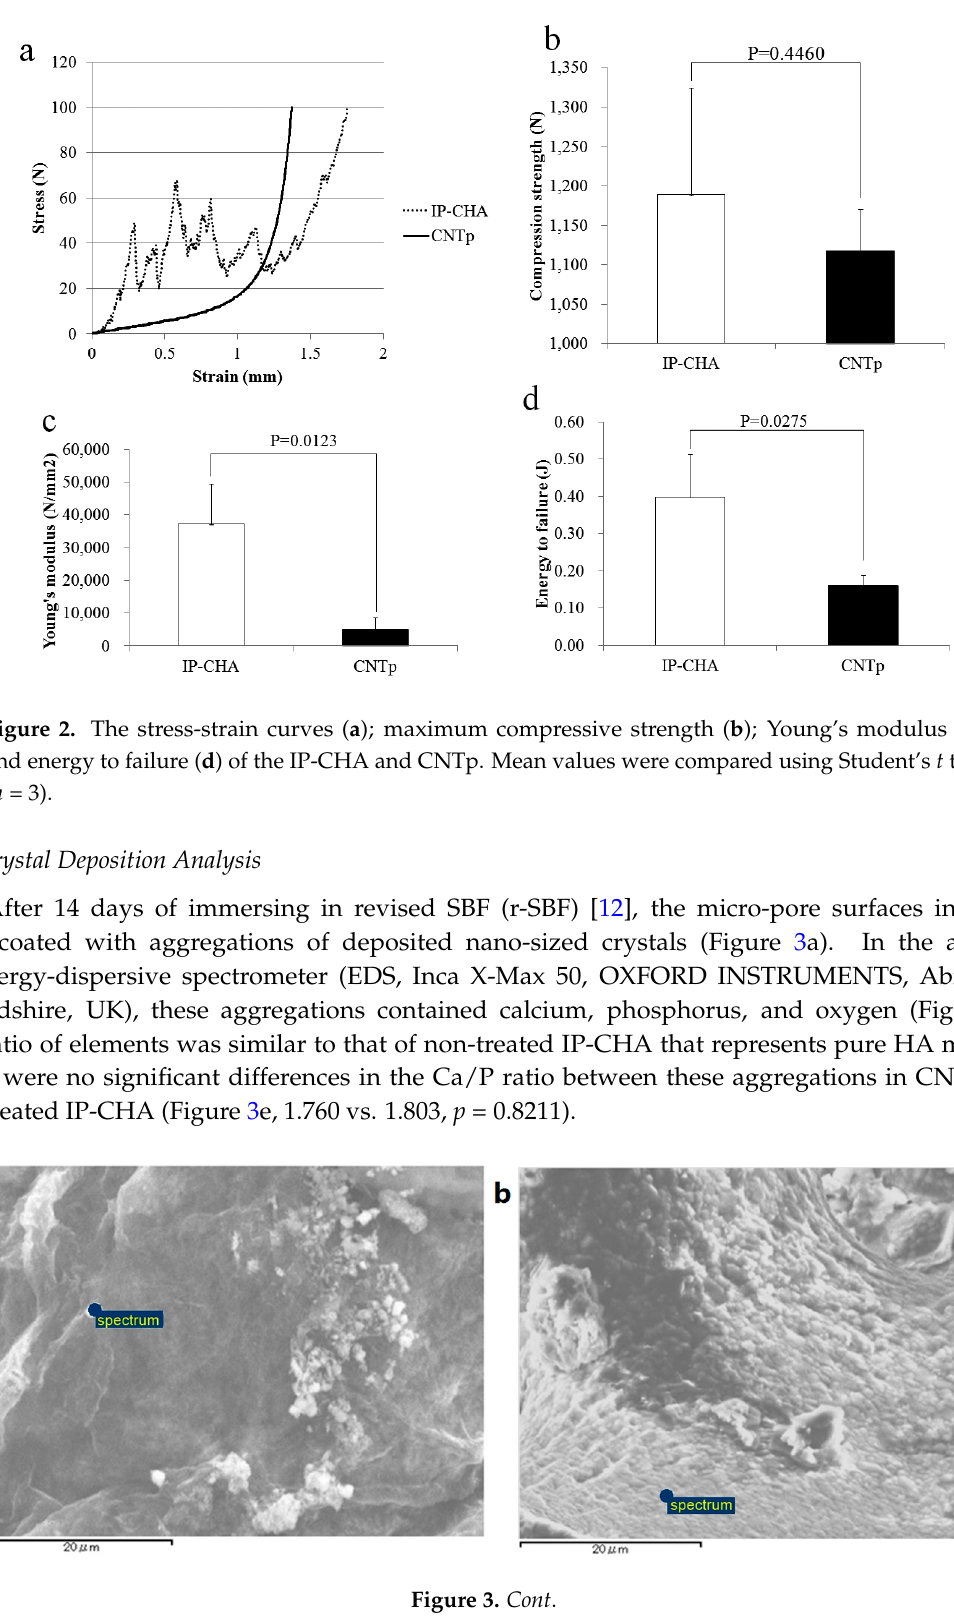
Figure 3. ( a ) SEM image of hydroxyapatite ‐ like crystal formation on CNTp scaffolds; ( b ) SEM image of a non ‐ treated IP ‐ CHA; ( c , d ) EDS on marked area revealed Ca, P, O in the crystal on ( c ) CNTp and ( d ) the surface of non ‐ treated IP ‐ CHA; ( e ) Ca/P ratio of the crystals appeared on the surface of CNTp and IP ‐ CHA. Mean values were compared using Student ʹ s t test ( n = 5). 2.4. Qualitative Protein Adsorption Profiles Each sample was immersed into 500 μ L of 500 μ g/mL Bovine Serum Albumin (BSA) solution (each solution contained 250 μ g of BSA). On day 0 (one hour of immersion), CNTps showed significantly faster protein adsorption than IP ‐ CHAs ( p = 0.0104). On day 4, CNTps decreased more protein concentration in the solution compared to IP ‐ CHAs ( p = 0.0006). Similar data was obtained on day 7 ( p = 0.0042). IP ‐ CHAs did not show further decrease of protein concentration on days 4 and 7 compared to day 0 (Figure 4). Total amounts of protein that adsorbed to CNTps and IP ‐ CHAs on day 7 were 100 μ g and 12 μ g, respectively. Considering the porosity of CNTps (99%) and IP ‐ CHAs (75%), the CNTps absorbed 6.3 times more protein than IP ‐ CHAs.